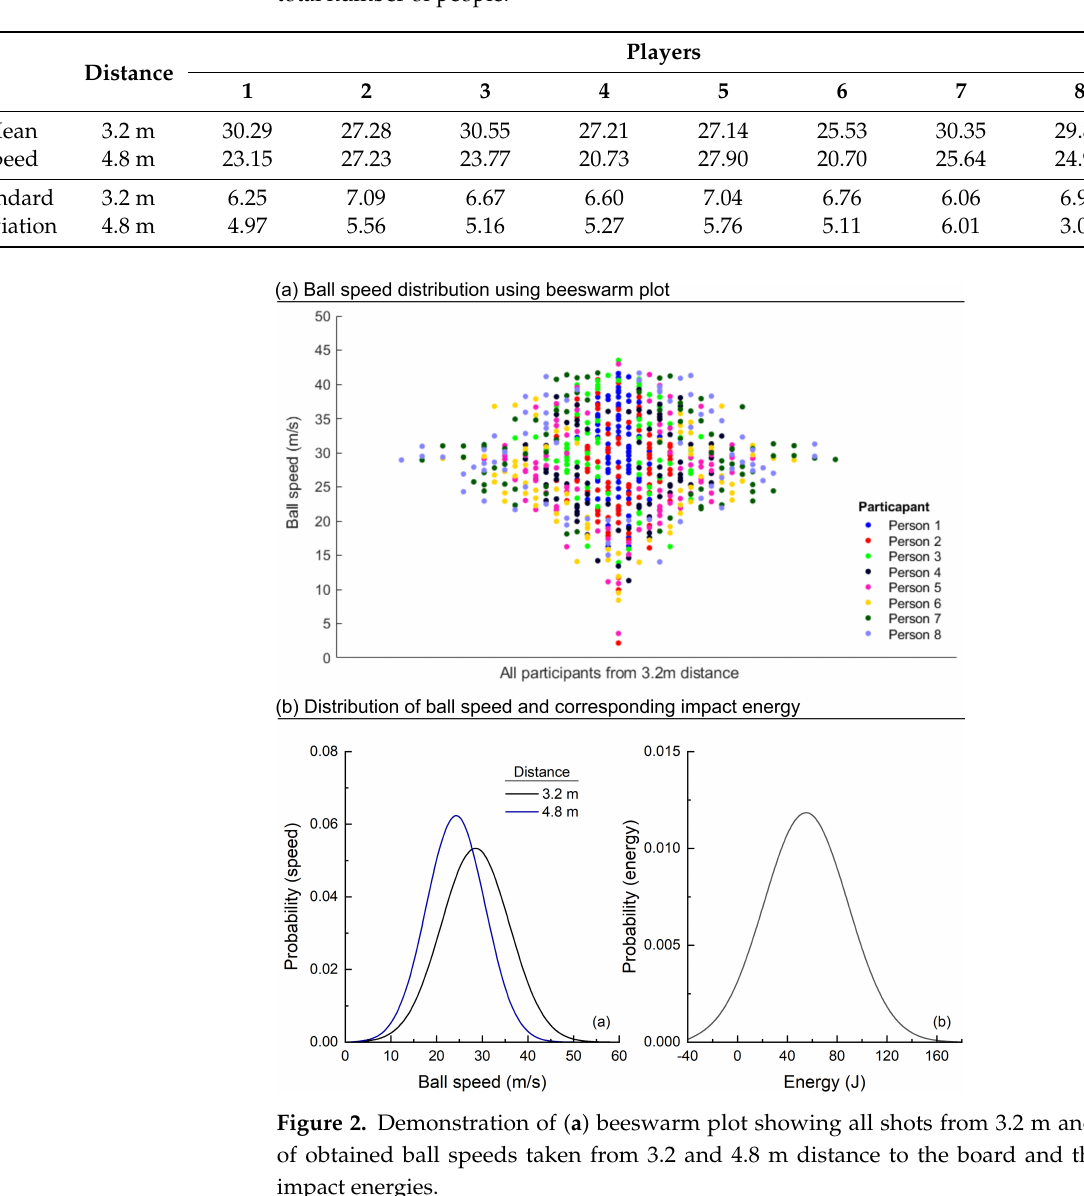
Table 1. Mean and standard deviation (ms − 1 ) of each data set including the total values across the total number of people.